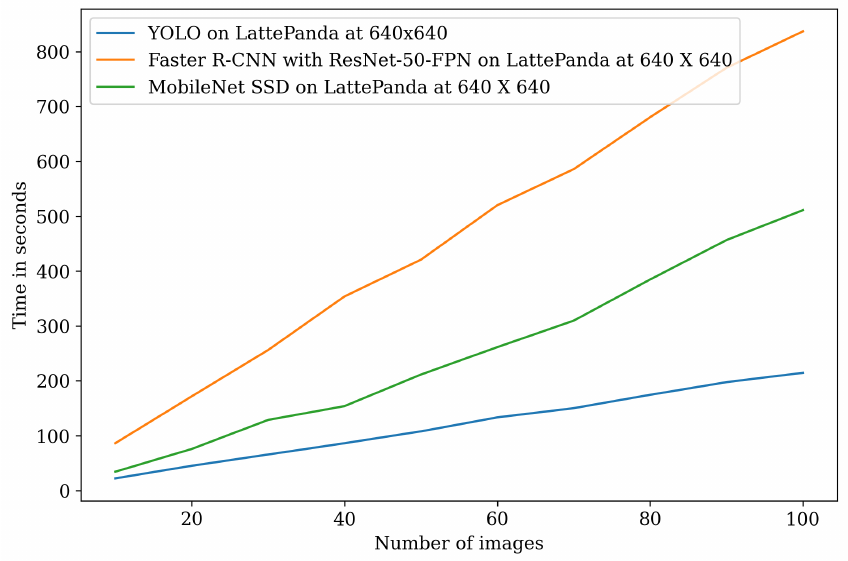
Figure 11. Time taken to perform wheat